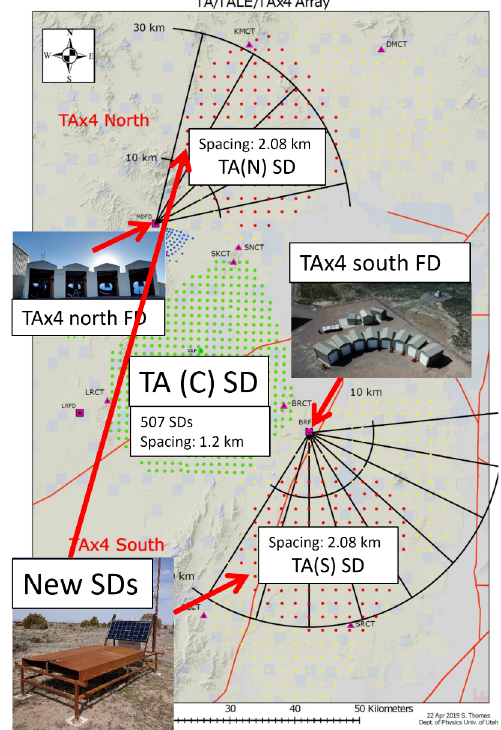
Figure 1. Map of the Telescope Array (TA) site. Each red cir- cle in the north (N) and south (S) corresponds to the location of a newly deployed TA surface detector (SD); the spacing of the SDs is 2.08 km. Each yellow circle denotes the future location of a planned TAx4 SD. Each green circle in the west shows the lo- cation of a TA SD that is located at the center (C) between north and south array; the spacing of these is 1.2 km. The two fan shapes drawn with black lines are the fields of view of the TAx4 fluorescence detectors (FDs). Four telescopes have been built in the northern Middle Drum FD station, and eight telescopes in the southern Black Rock FD station. The overlap of the locations of the SDs and the fields of view of the FDs enables SD-FD hybrid observation. Pictures of new SDs and FDs are also